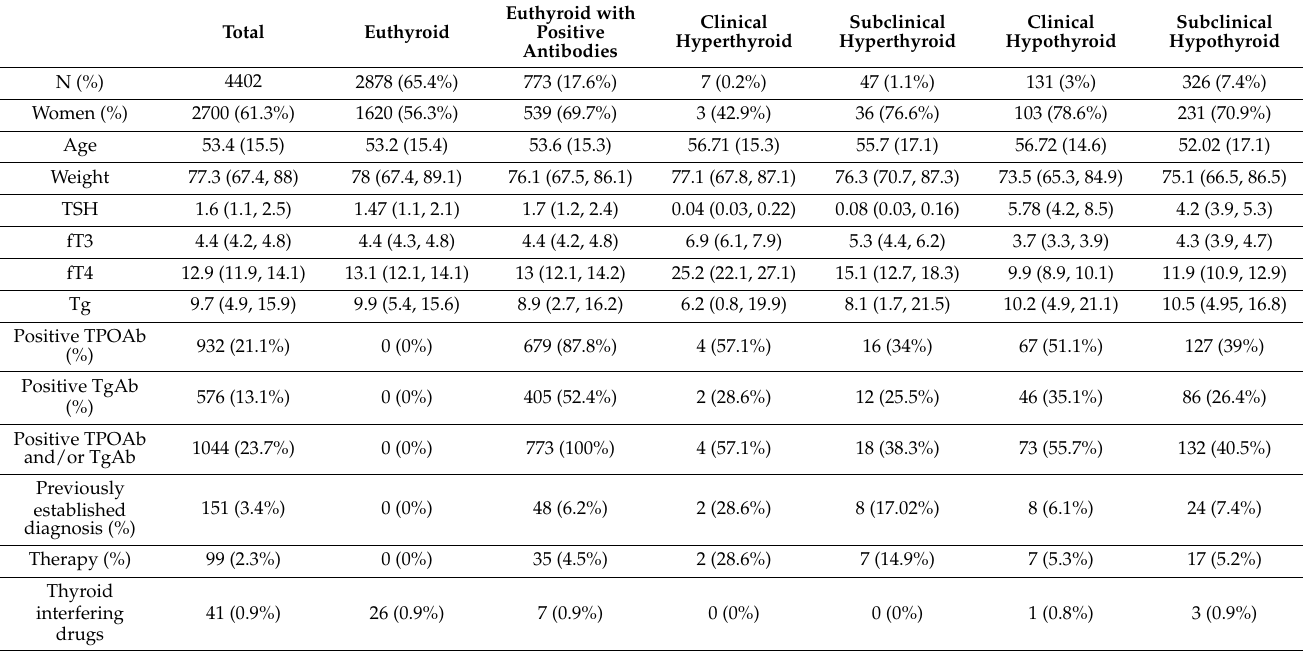
Table 2 includes a detailed cross-tabulation overview of thyroid therapy intake and clinical thyroid diseases across thyroid function groups and previously established diagnoses. Women had a higher prevalence of euthyroidism with positive antibodies, subclinical hyperthyroidism, subclinical hypothyroidism and clinical hypothyroidism, while men had a higher prevalence of euthyroidism (Table 3). Out of the 2700 women in our study, 1049 were 50 years old or younger (with mean age 37.3 in the euthyroid, 36 and 34.4 in the clinically and subclinically hyperthyroid, 37 and 35.7 in the clinically and subclinically hypothyroid and 38 in the euthyroid with positive antibodies group). Table 1. Clinical characteristics of study participants.